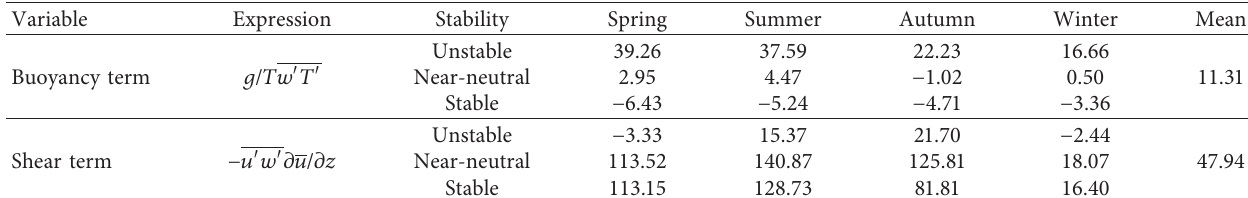
Table 4: Turbulent kinetic energy budget for different seasons and stability conditions. Variable Expression Stability